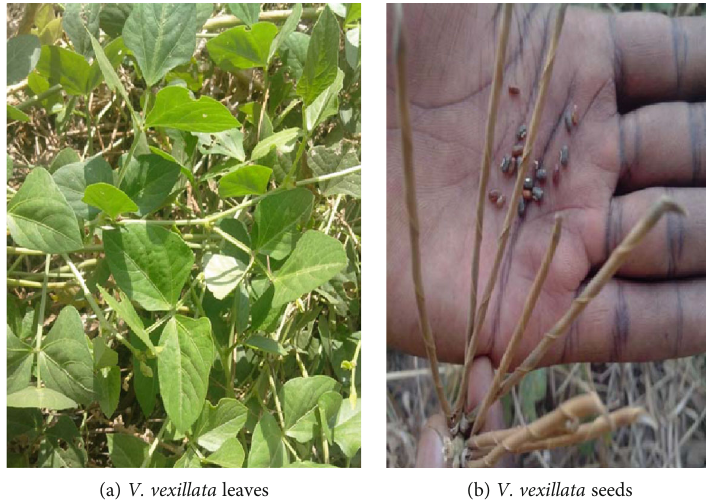
Figure 2: (a) V. vexillata leaves. (b) V. vexillata seeds. Source: Field survey, 2017.